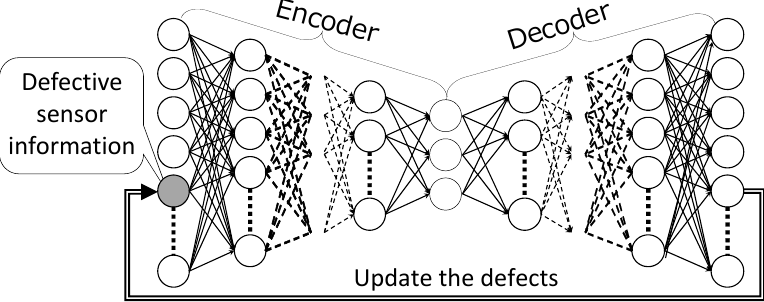
Figure 2. DSAE-FP: Repair the defects in sensor time-series data by updating to the reconstructed time-series